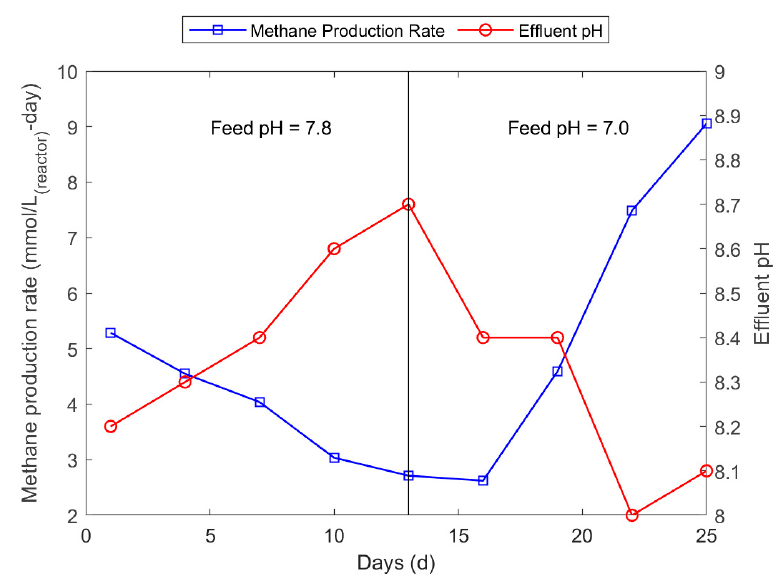
Figure 5. Methane production rate and effluent variation with feed pH.